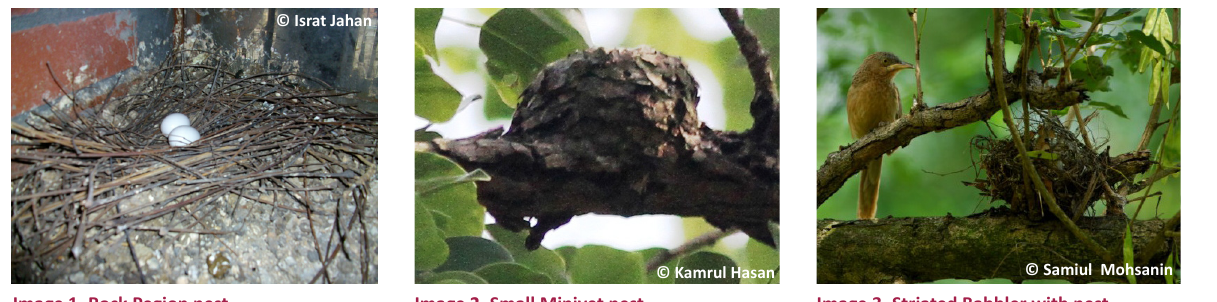
Image 3. Striated Babbler with nest